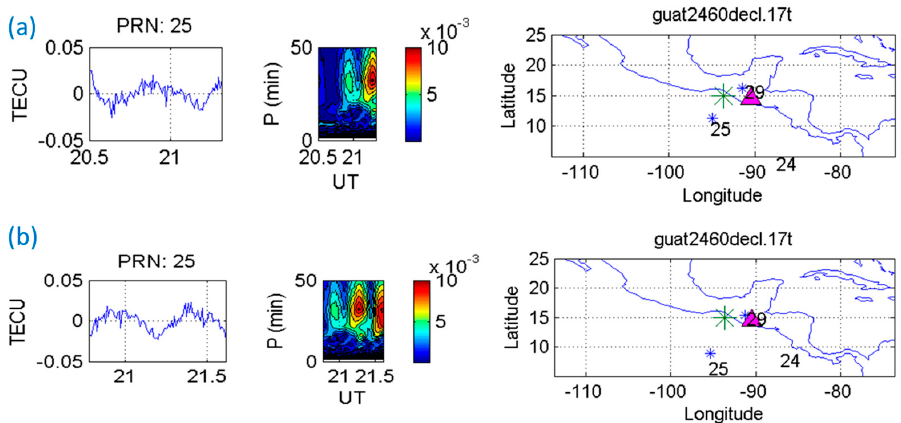
Figure 7. Fluctuations of differential slant TEC obtained from GUAT station and PRN satellites passing over the earthquake preparation area on 3 September 2017 (DoY 246) at: ( a ) 20.5–21.5 UT (upper panel) and ( b ) 21–21.5 UT (lower panel). Power spectrograms of normalized amplitude are also shown. Maps show earthquake epicenter (green asterisk), GUAT station (pink triangle), number and position of satellite (blue asterisks). Geosciences 2021 , 11 , x FOR PEER REVIEW